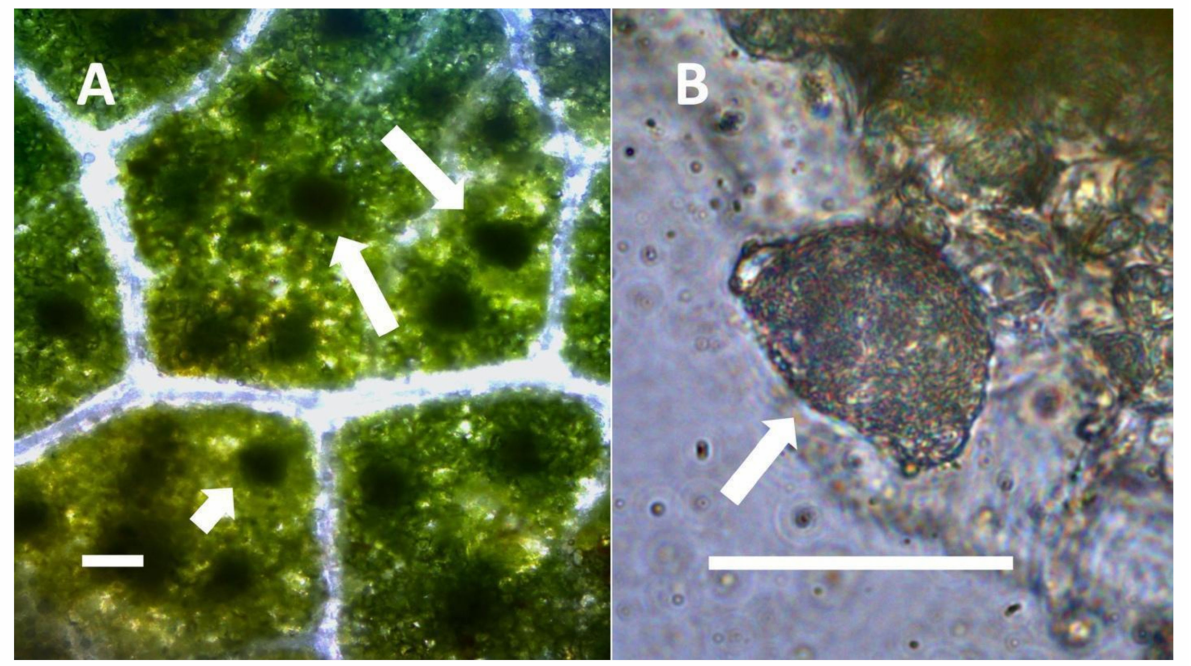
Figure 11. Thespesia populnea leaf nodule bacteria. ( A ) Leaf stained with acidified diphenylamine to show bacterial masses (leaf nodules; arrows) (Bar = 50 µ m). ( B ) Mass of bacteria (arrow) from leaf nod- ule stained with acidified diphenylamine to show nitrate (blue color) around bacteria (Bar = 50 µ